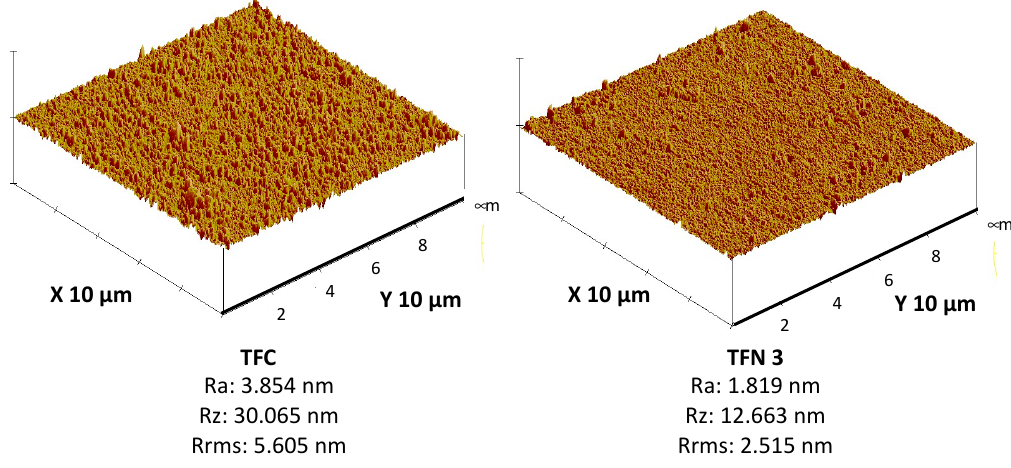
Figure 3. AFM analysis of TFC and TFN 3 membranes.